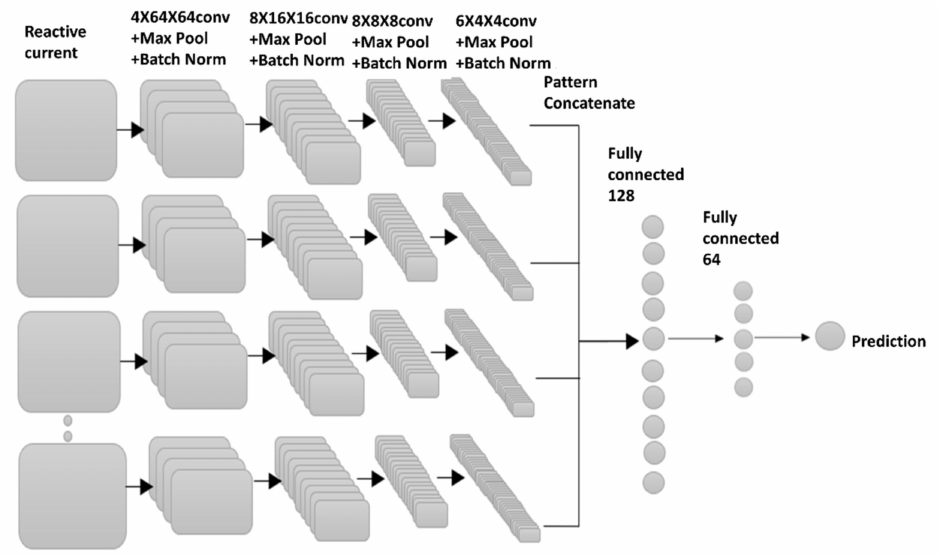
Figure 14. Classification core CNN architecture used once cascaded to E-CPC, second time cascaded to FFT of raw data, and a third time to raw